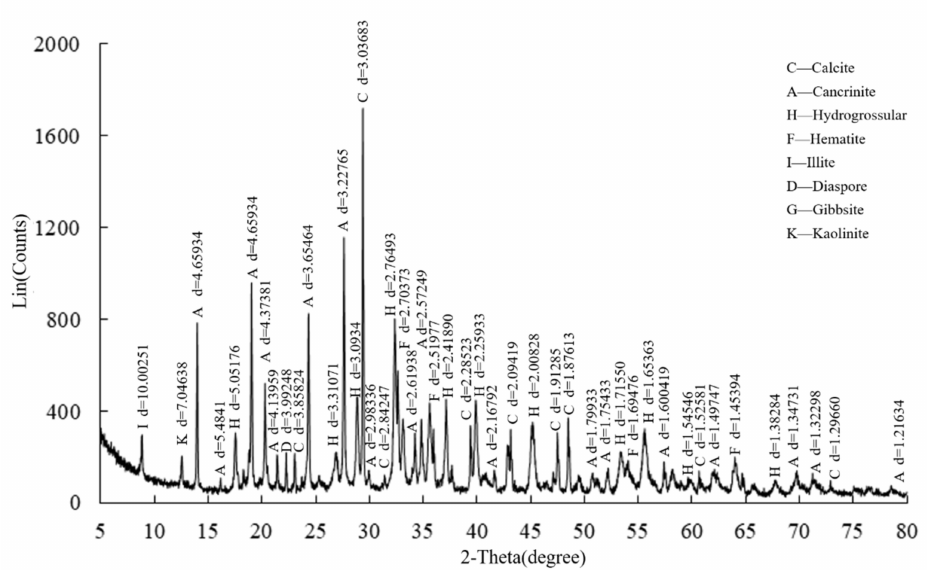
Figure 3. XRD results of red mud from the Bayer